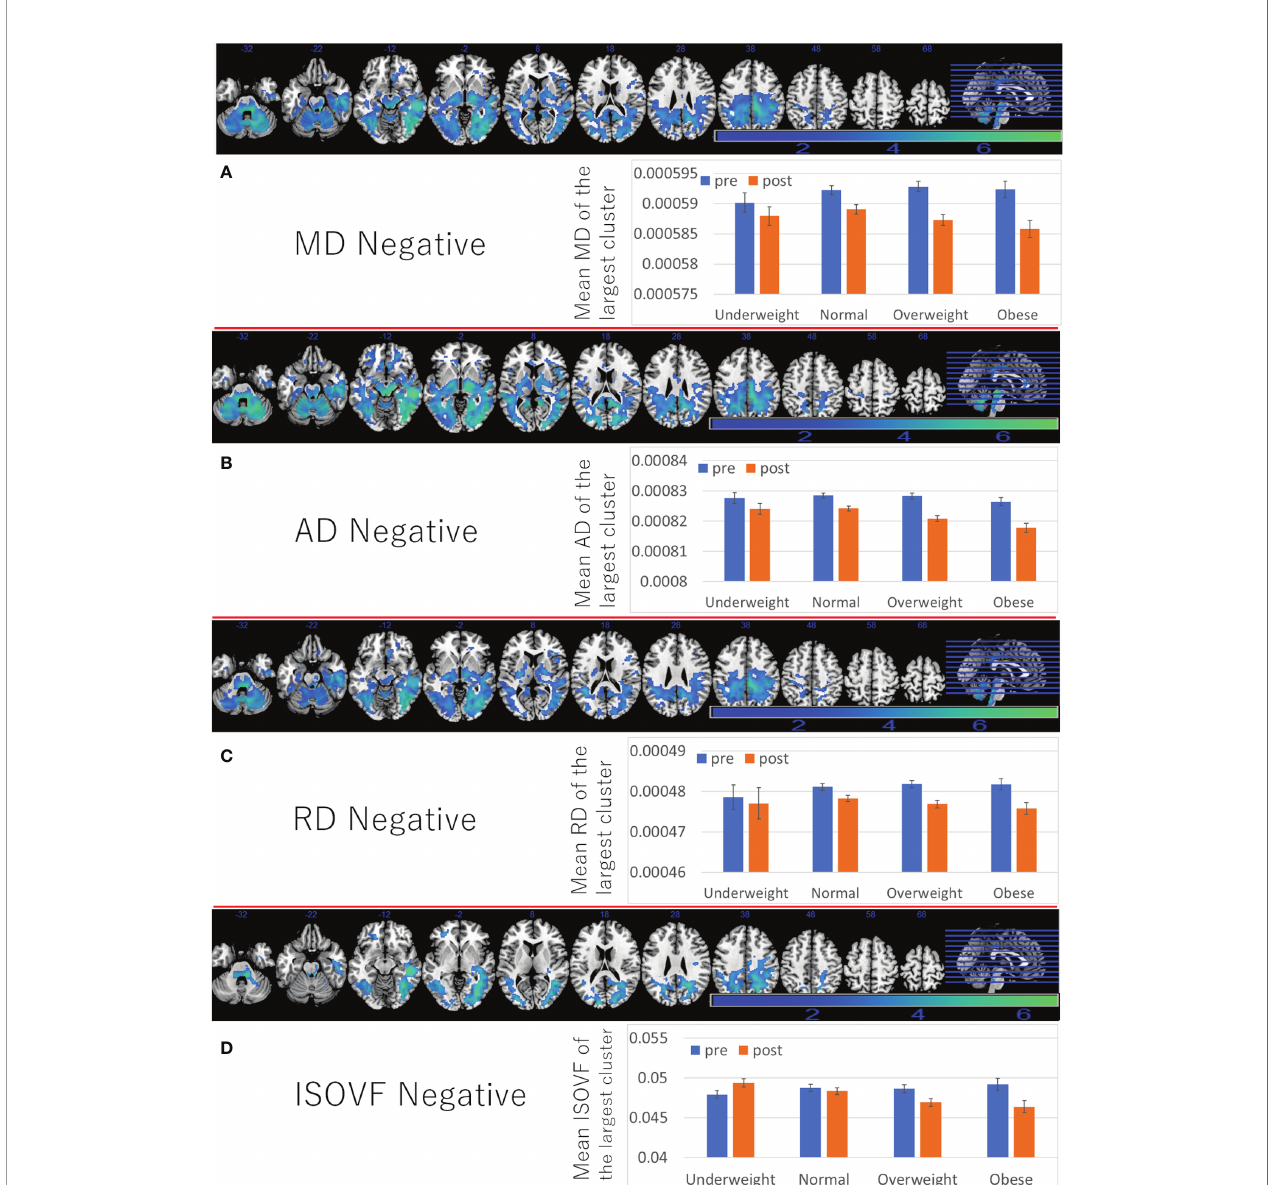
FIGURE 5 | Associations between BMI and subsequent longitudinal changes in brain imaging measures. Negative associations between BMI and (A) MD change, (B) AD change, (C) RD change, (D) ISOVF change. (left panels) Results are shown with a threshold of P < 0.05 and corrections for multiple comparisons in cluster size tests with a voxel level cluster determining threshold of P < 0.05 (corrected for FDR). Areas of signi fi cant associations were overlaid on a “ ch2bet ” image using MRIcron (https://www.nitrc.org/projects/mricron) and in slices (from the left) of z = -32, -22, -12, -2, 8, 18, 28 38, 48, 58, and 68. The color represents the strength of the T value. (Right panels) Pro fi les of imaging values at pre and post scans (which correspond to the third and the fourth assessment visits) in the largest signi fi cant clusters of each